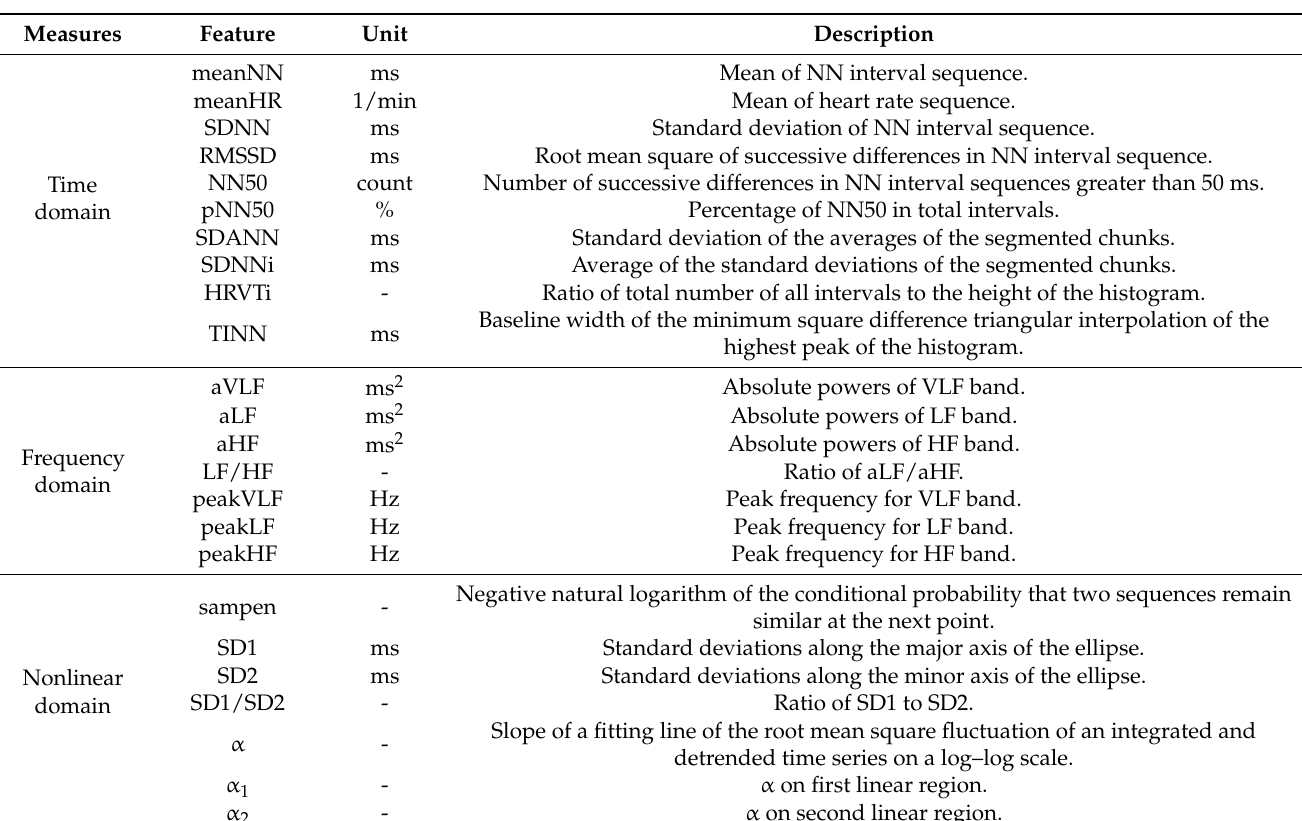
Table 4. All HRV